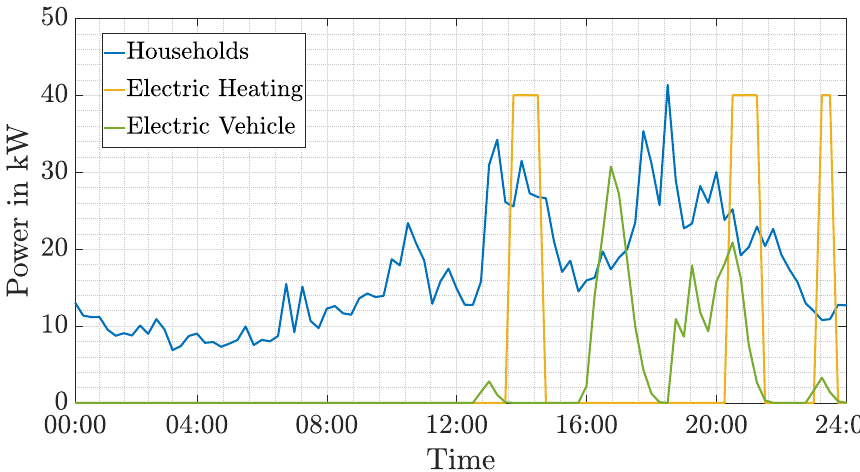
Figure 4. Profiles for the energy consumption of the households and electric heating as well as EV